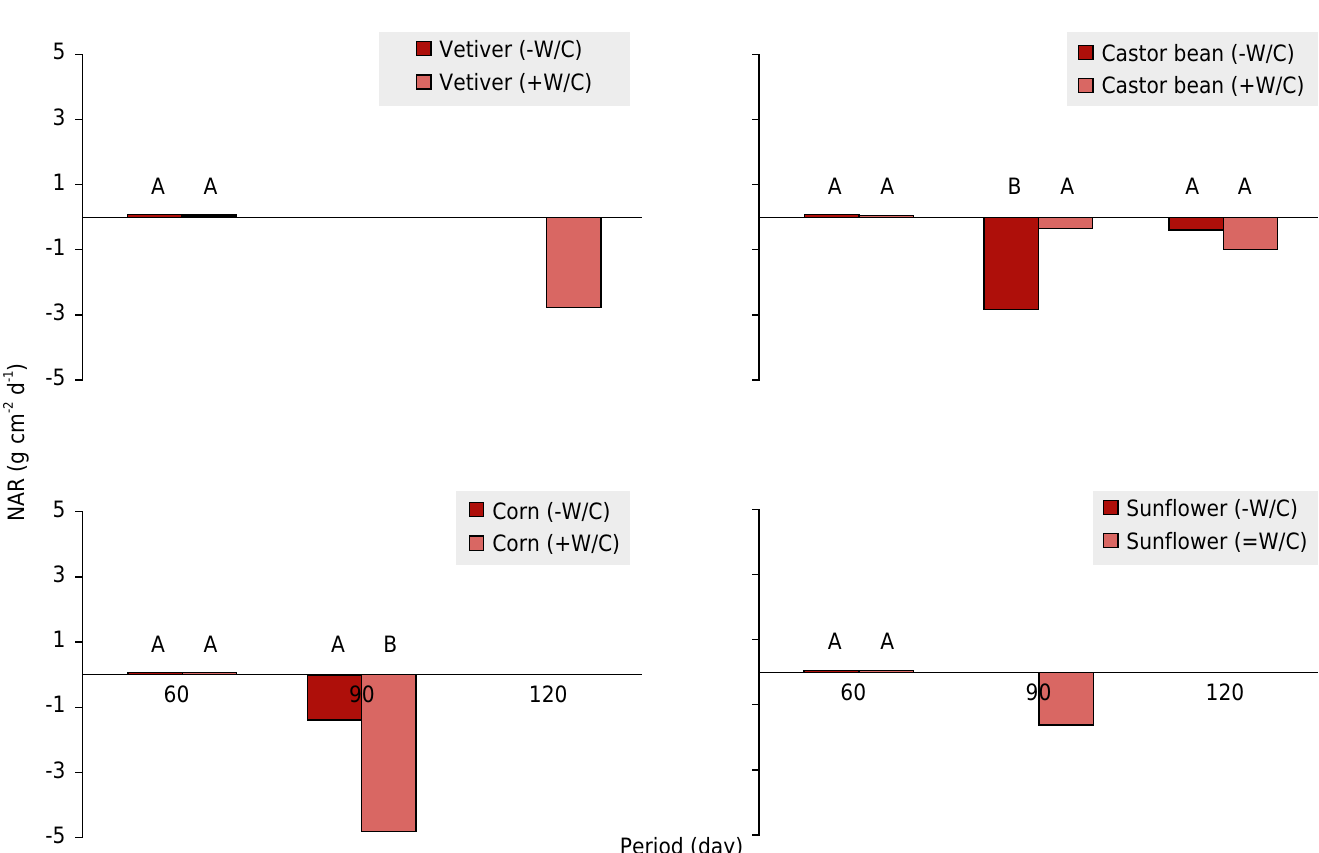
Figure 2. Net assimilatory rate (NAR) in vetiver, castor bean, corn, and sunflower plants conducted in soil contaminated with lead, without (-W/C) and with (+W/C) correction of soil pH, at 60, 90, and 120 days after planting (DAP). Means followed by the same letter, within each period, do not differ among